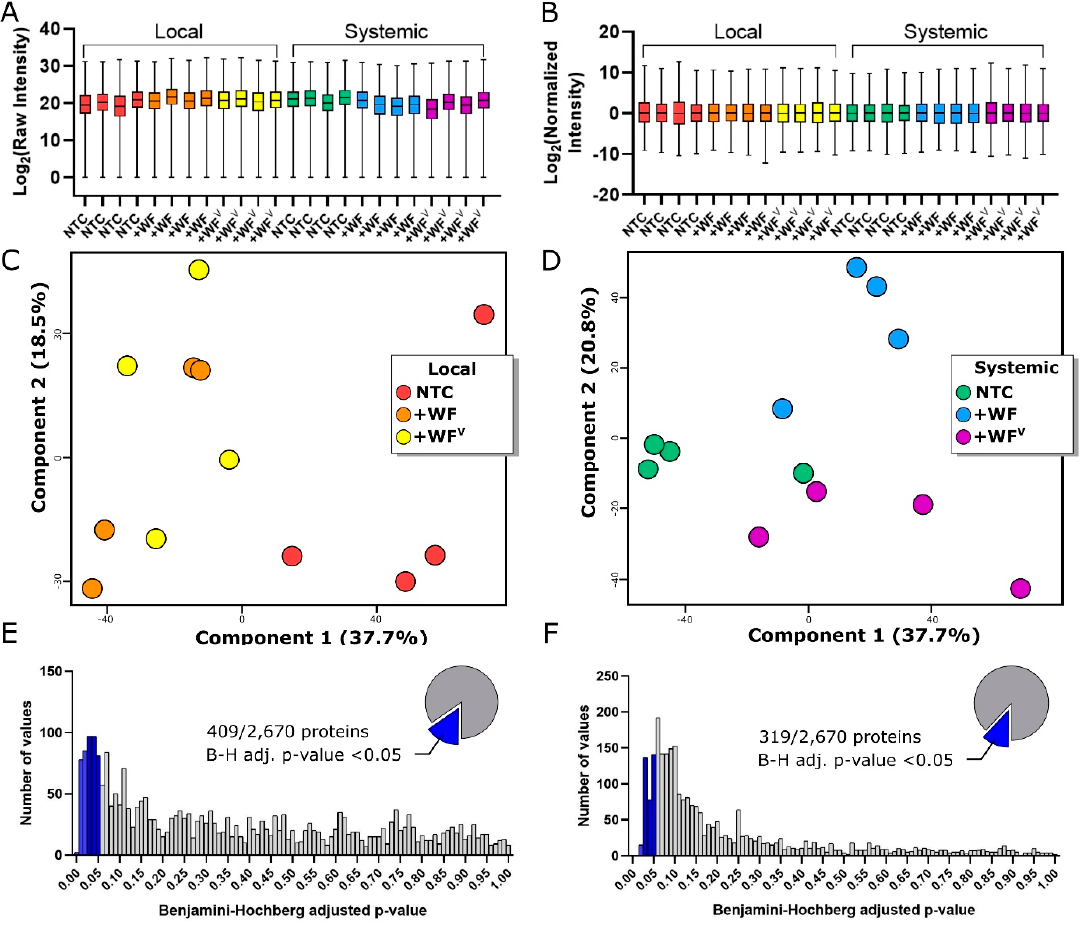
Figure 2. ( A , B ) Range of protein abundances pre-normalization ( A ) and post-normalization ( B ). ( C , D ) Principal component analysis for both local ( C ) and systemic ( D ) leaves collected 3 dpf and 10 dpf, respectively. Distribution of ANOVA p -values indicate the abundance of 409 and 319 proteins are significantly changed in local leaves at the SOF 3 dpf ( E ) and systemic leaves ( F ), respectively, after Benjamini–Hochberg multiple hypothesis test correction using a 5% false discovery rate